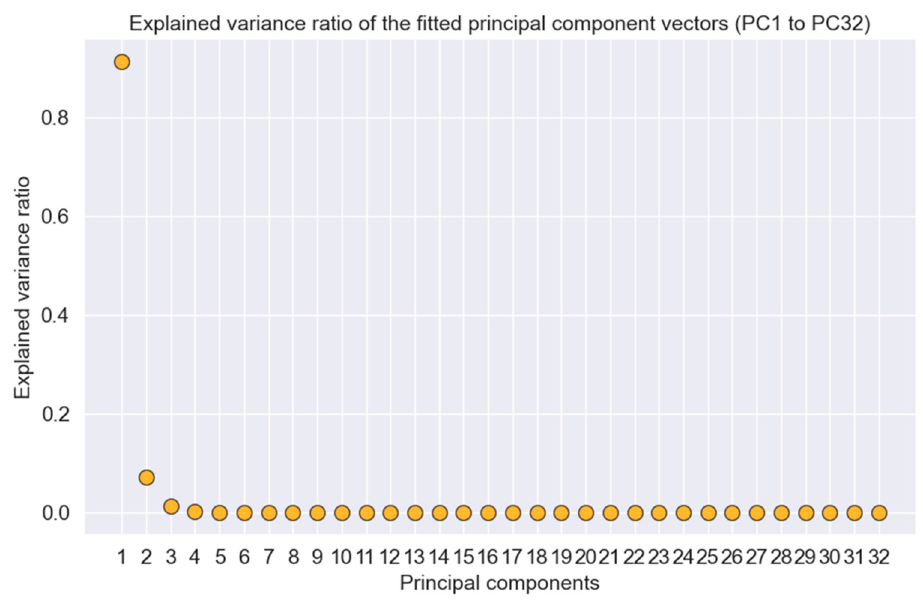
Figure 9. Explained variance ratio for 32 principal components.